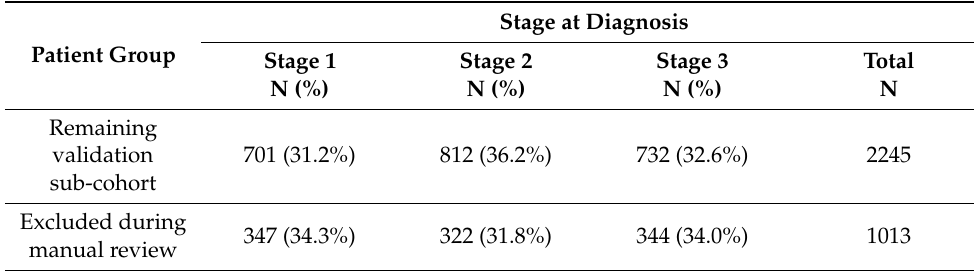
Table A8. Stage at diagnosis among patients excluded during manual review and patients remaining in the validation